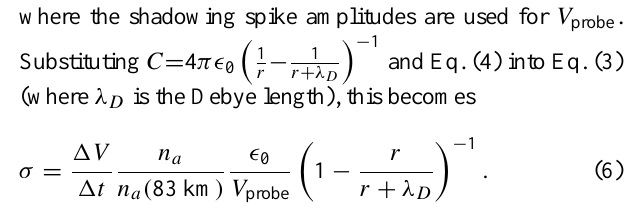
Fig. 8. Spectrogram of E 12 around the PMSE layer. The layer can be seen around 83–88km. The high-frequency fuzz is probably auroral hiss, which shows that the instrument accurately measured high frequency